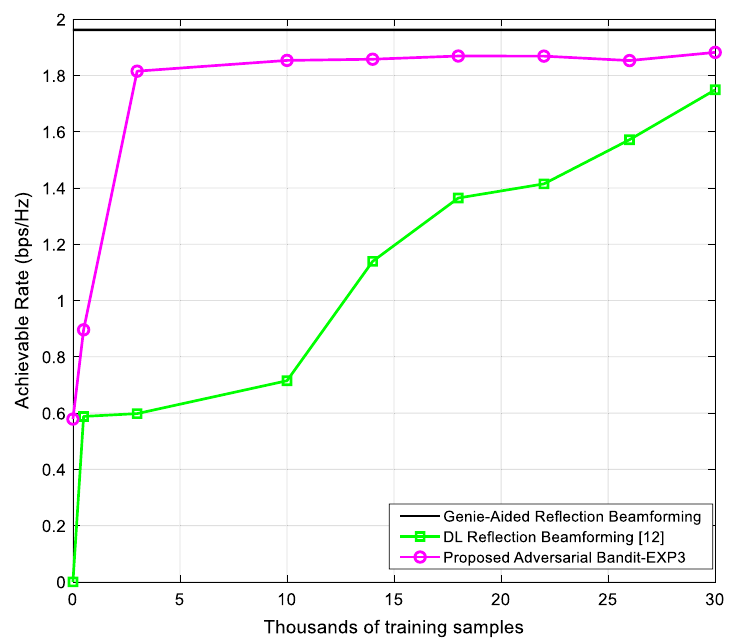
Fig. 3 The achievable rate versus the number of training data of the proposed EXP3-based scheme in comparison with the reference DL reflection beamforming [26] and the reference genie-aided method (that assumes perfect knowledge of the channel) where M =